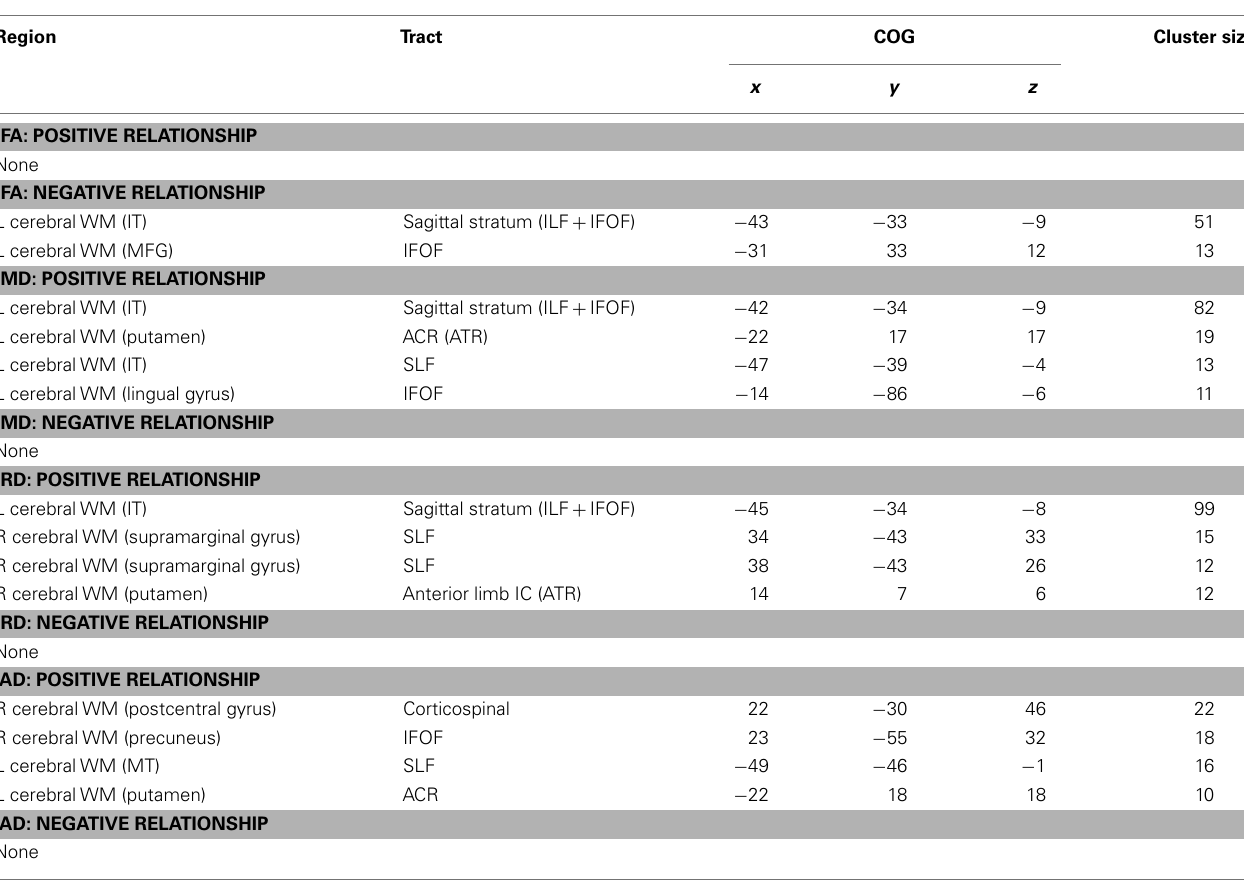
Table 5 |Voxel-wise correlations with irritability.